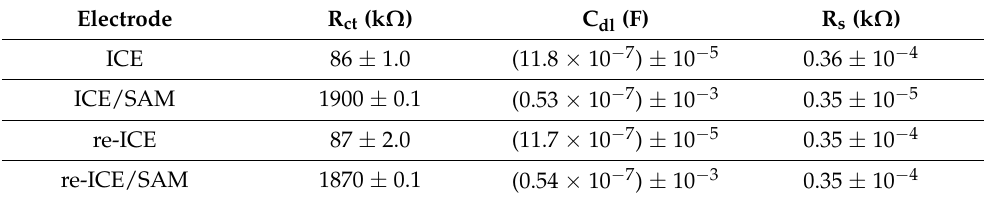
Table 1. EIS parameters of the electrode and the modified electrode, extrapolated by fitting the measured spectra in Figure 5 to the REC.